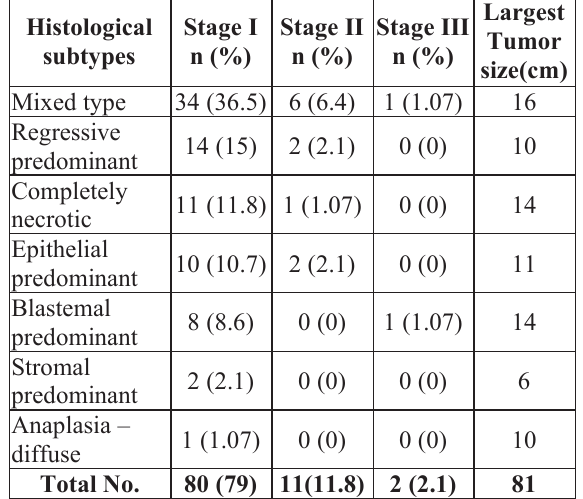
Table-2: Histological subtypes, staging and largest tumor size according to SIOP 2001.